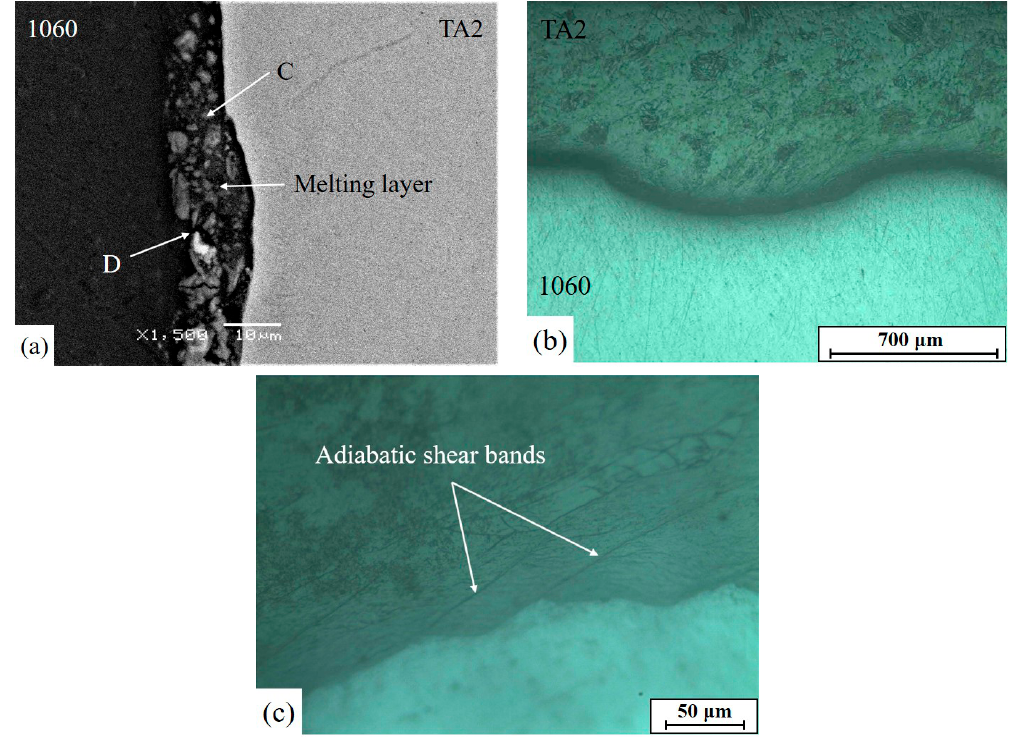
Figure 4. Microstructure of the bonding interface of sample 2: ( a ) melting layer; ( b ) big wave bonding interface; ( c ) adiabatic shear bands.